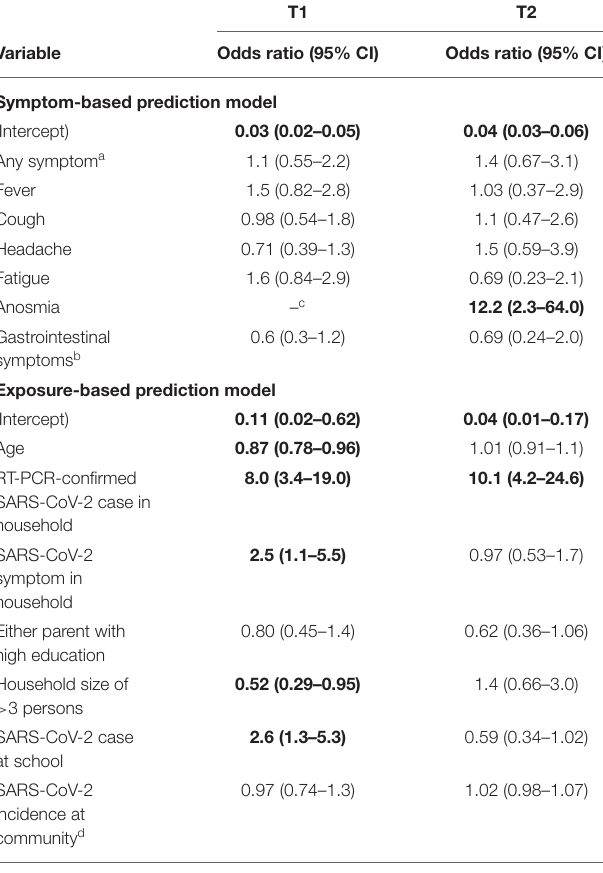
TABLE 3 | Multivariable logistic regression models assessing the predictive effect TABLE 2 | Univariate analysis of symptom and exposure variables assessing the of symptoms and of exposure variables on SARS-CoV-2 seropositivity. predictive effect on SARS-CoV-2 seropositivity. T1 T2 T1